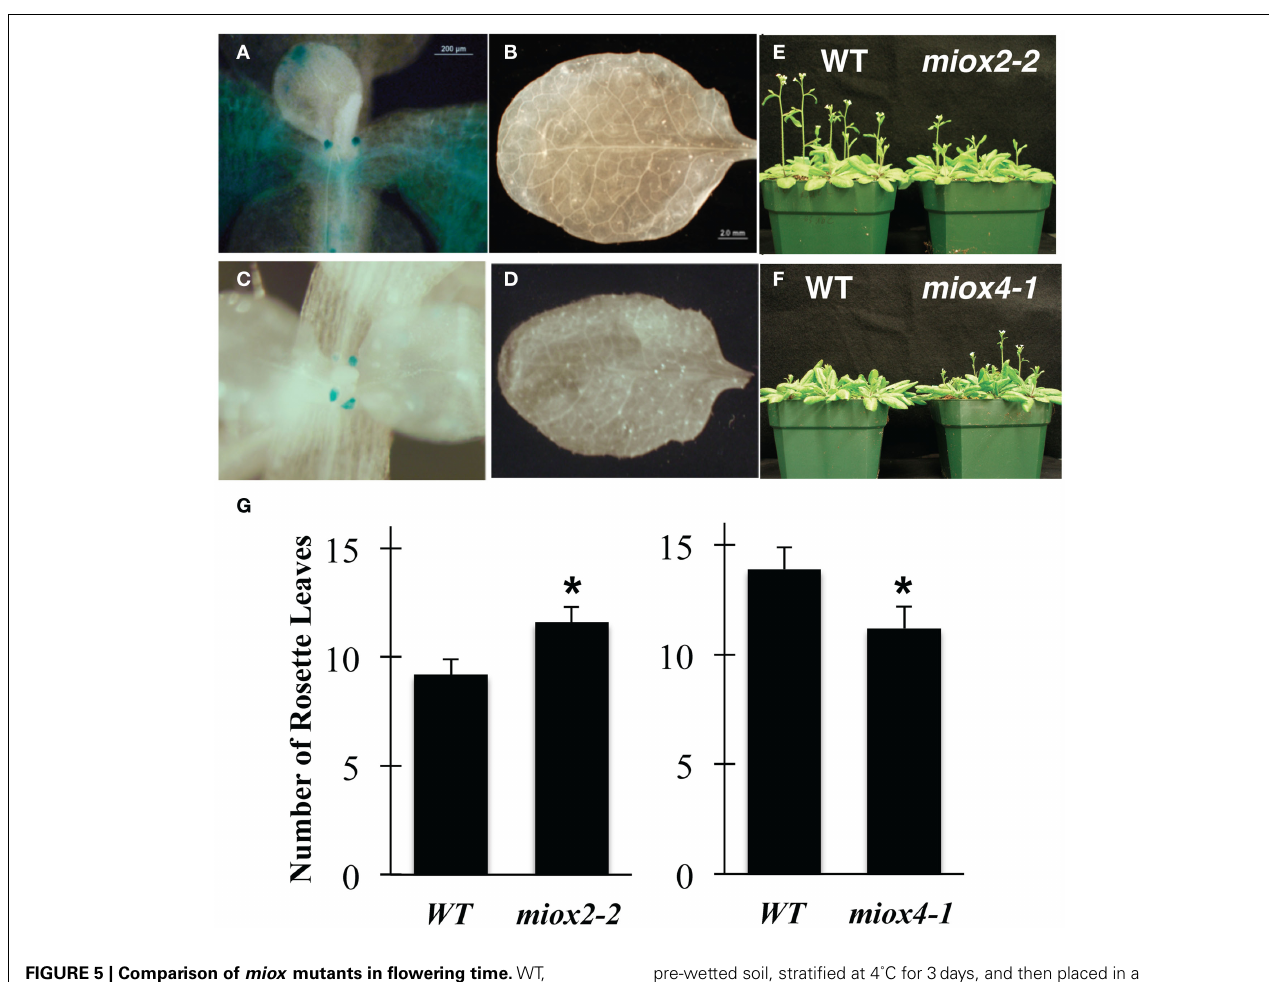
FIGURE 5 | Comparison of miox mutants in flowering time. WT, MIOX2p:GUS (A,B) , and MIOX4p:GUS (C,D) tissues were examined for GUS activity. Pictures are representative of staining patterns observed in 5–10 samples.WT samples showed no staining (not shown). (E,F) WT, miox2-2 , and miox4-1 mutant seeds were sown on